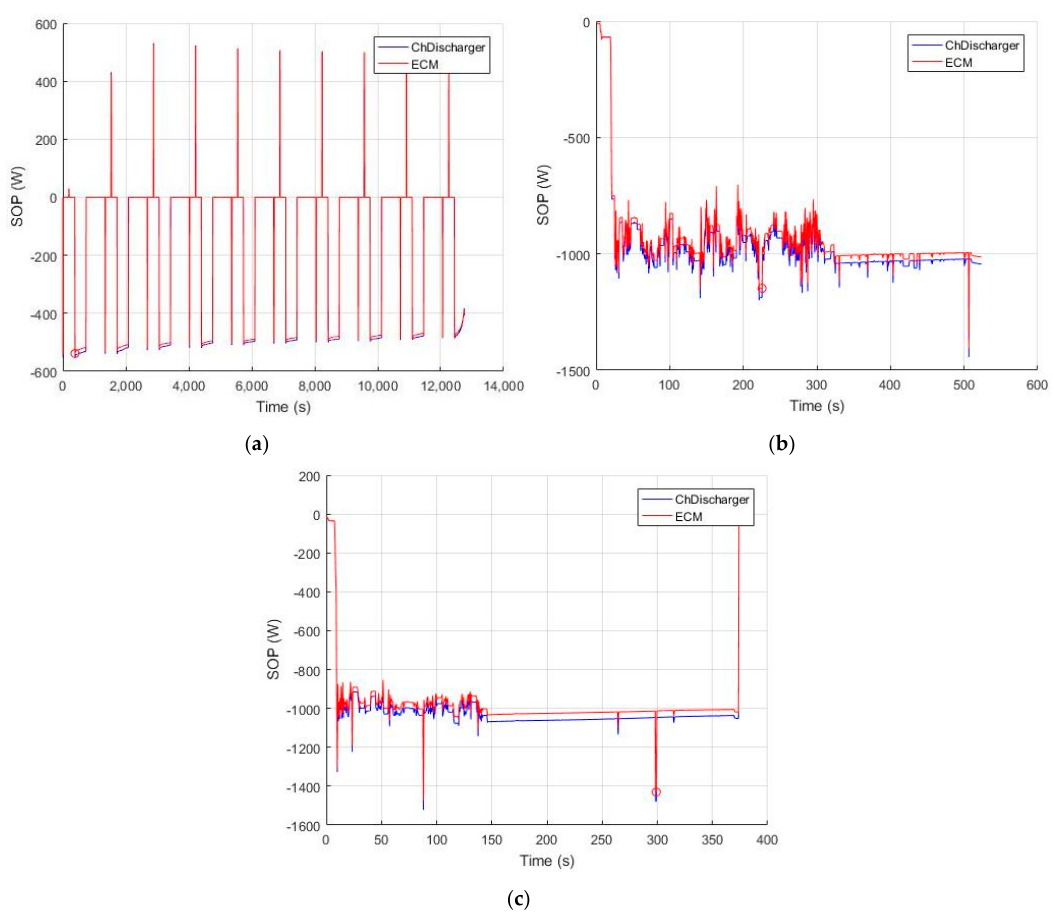
Table 5. Outdoor test result (0 kg payload).